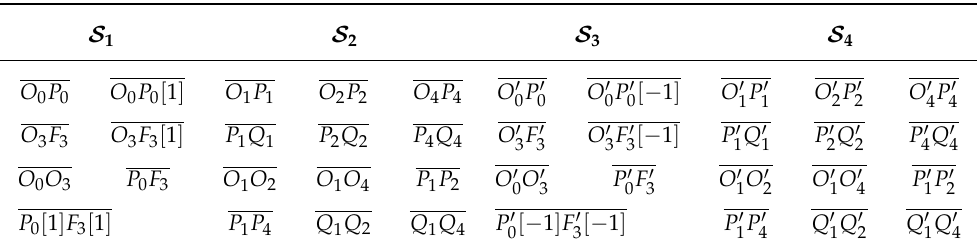
Table A1. Defining the edges in Miura-ori based, smooth sheet attachments for a pair of asymmetric zipper-coupled